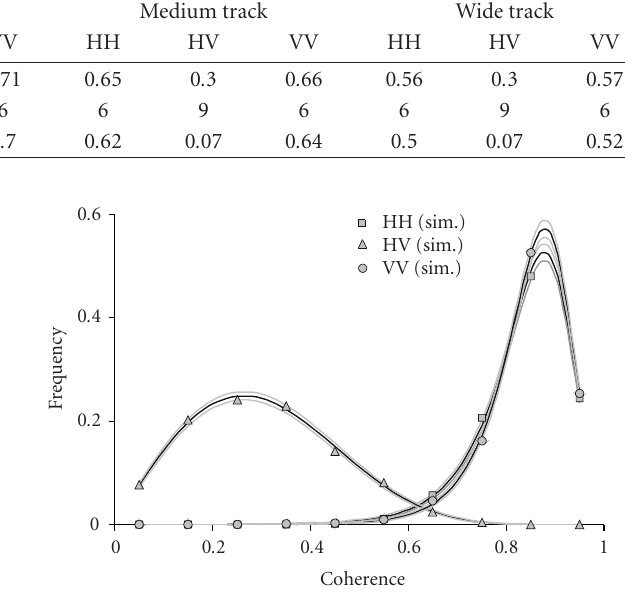
Figure 2: Simulated coherency distributions for the case of “no change” and the fitted theoretical distribution by polarimetric chan- nel. Light-shaded curves indicate expected standard deviations in frequency based on a binomial random process for the number of samples in a histogram